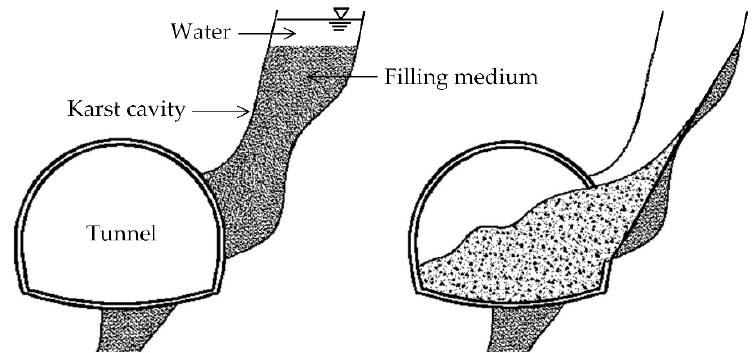
Figure 1. Schematic diagram of water–sand inrush during underground construction.